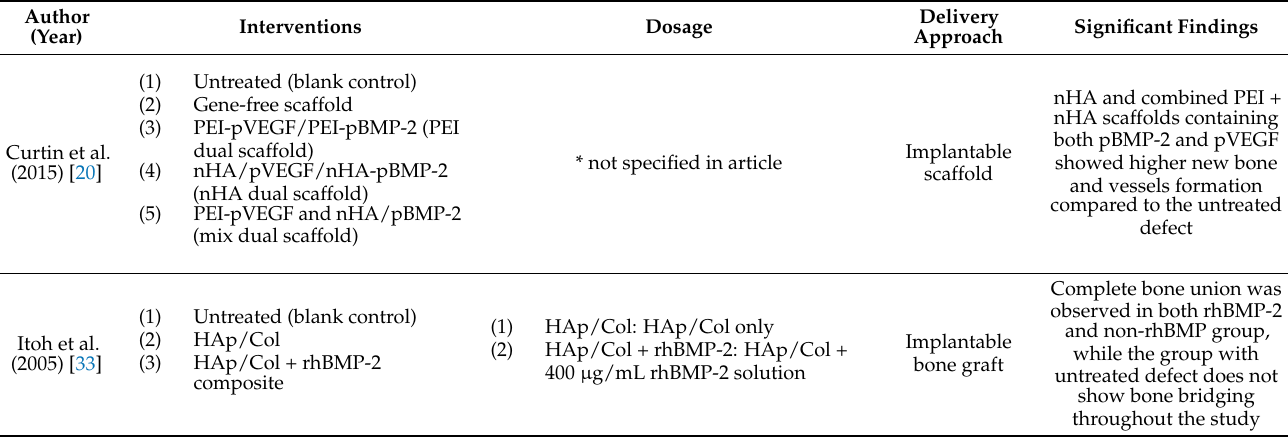
Table 3. Application of nHA for delivery of